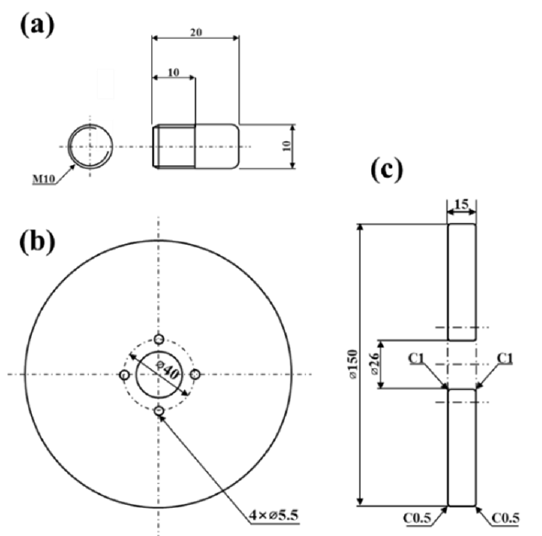
Figure 1. Specifications of ( a ) block, ( b ) disk, and ( c ) rod of experimental setup used for frictional wear test.